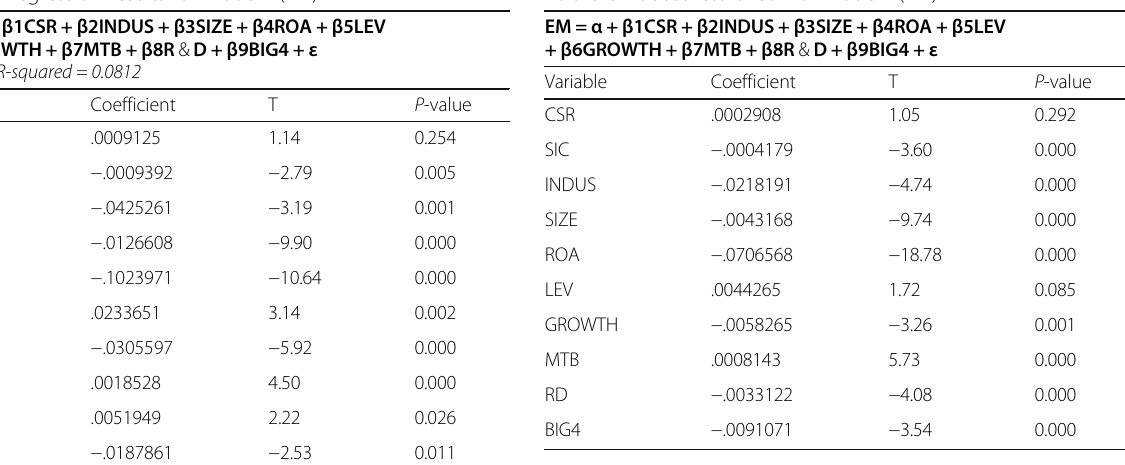
Table 8 Robustness check for Model I (EM)